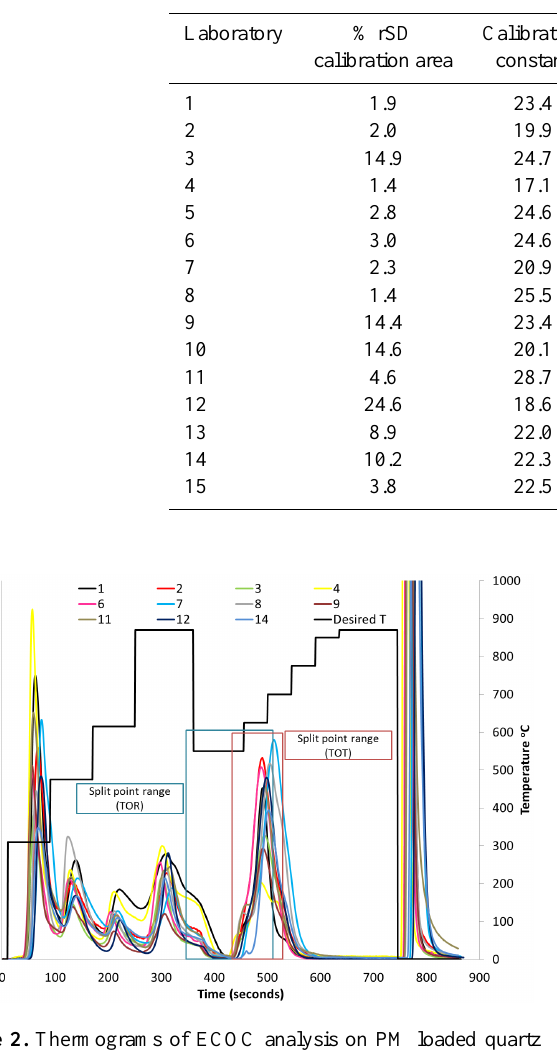
(OC2) for EUSAAR2 (Fig. 8). Similarly to filter A,